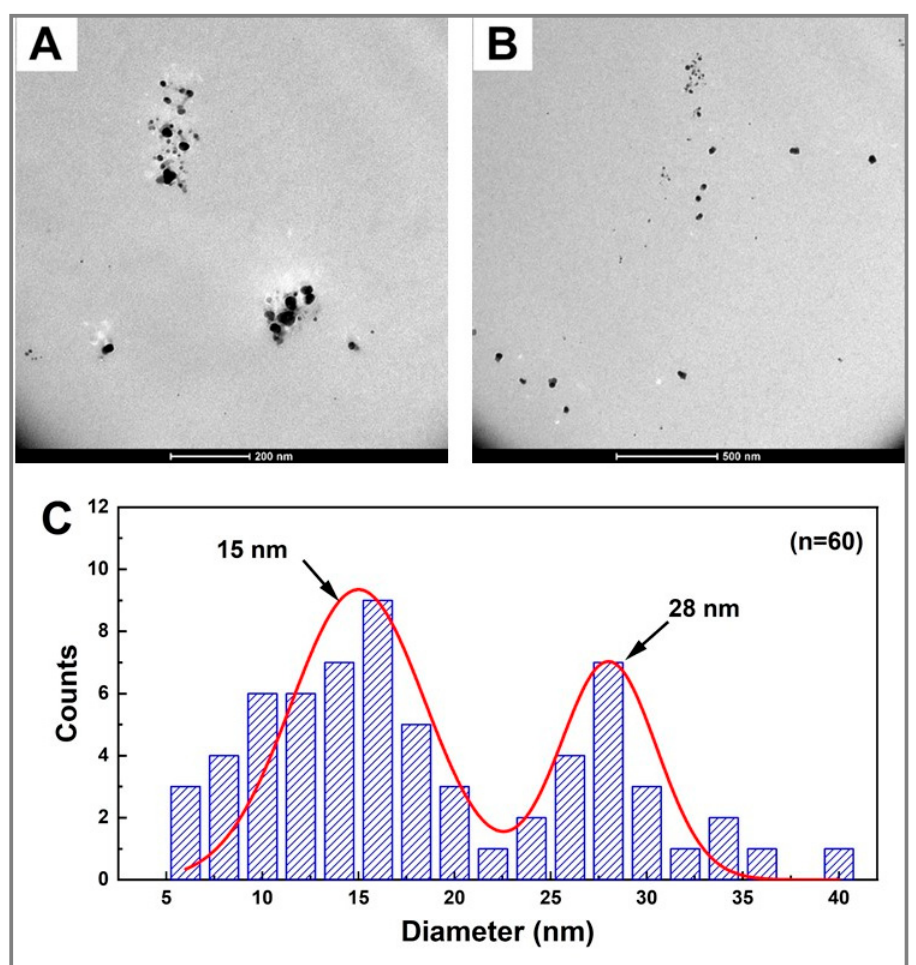
Figure 6. TEM micrographs of colloidal Ag 2 Se NPs from sample E 3 . ( A , B ) TEM images at different magnifications where the NPs are the black spots, and ( C ) histogram plot with the average size values of Ag 2 Se NPs ( n = 60).